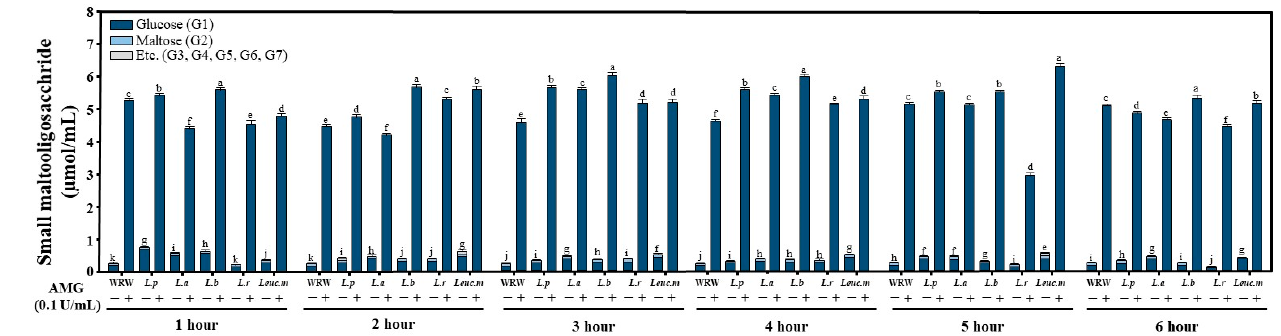
Figure 2. Analysis of the changes in the small MOS content during lactic acid fermentation. In all fermentation groups, the AMG enzyme-treated group had ≥ 10 times the total sugar content of the non-enzyme-treated group. Different letter in the same time zone means significantly different.